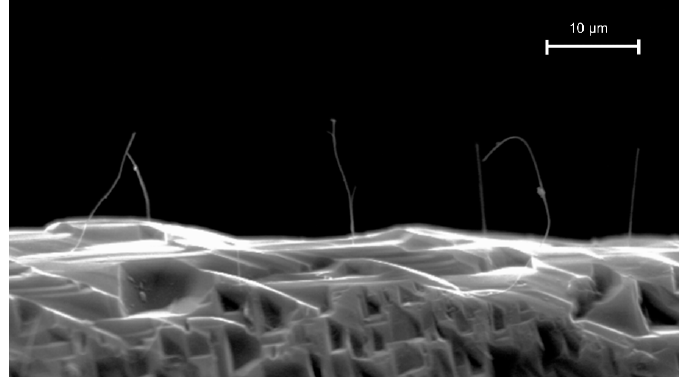
Figure 3. MWCNTs type NM-401 standing on a PEDOT:PSS film at one edge of the piezo quartz.